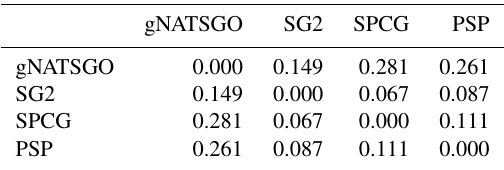
Table 5. The Jensen–Shannon distance between co-occurrence vec-